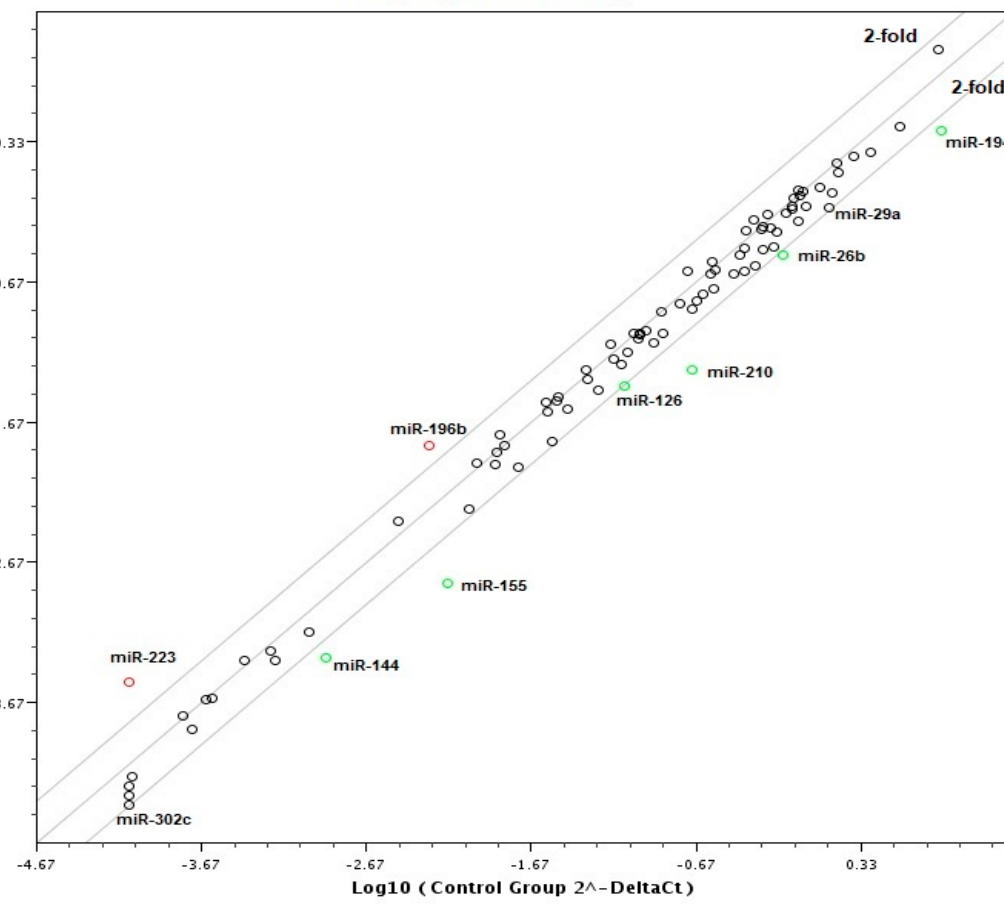
Figure 3. Scatter plots of miRNAs expression in untreated cells versus Caco-2 cells treated with 5 mM IP6 (x-axis represents the 2 − ∆ Ct value of control cells, and y-axis represents the 2 − ∆ Ct value of IP6-treated cells). The expression value of each human miRNA was plotted as a scatter plot, and threshold lines were drawn at a 2-fold expression change.